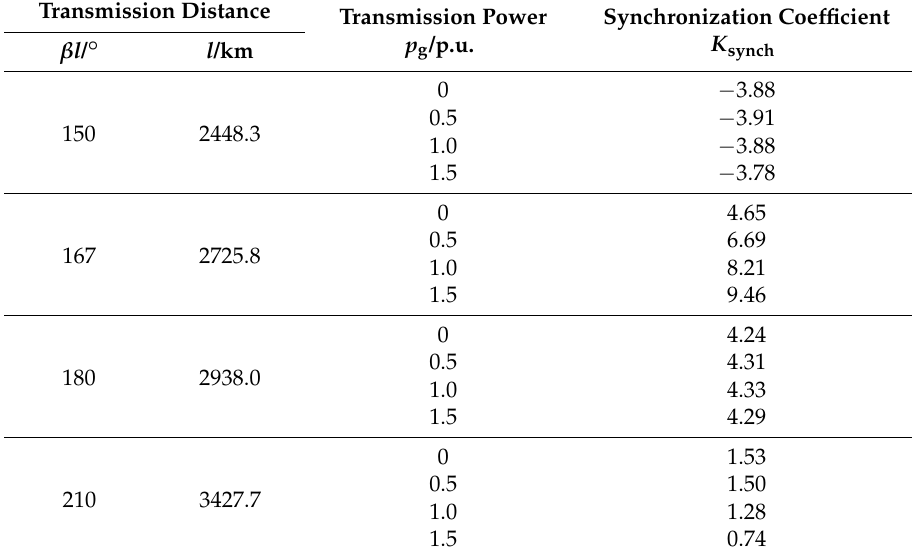
Table 4. Description of specified points in Figure 4.